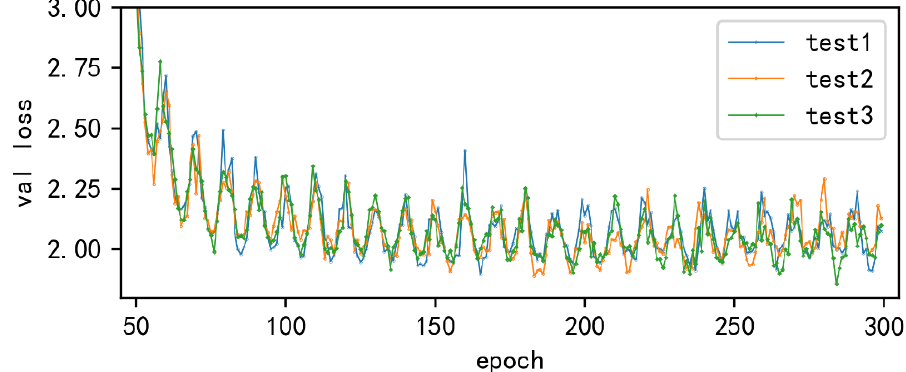
Figure 9. Validation loss of training with different regression angles.